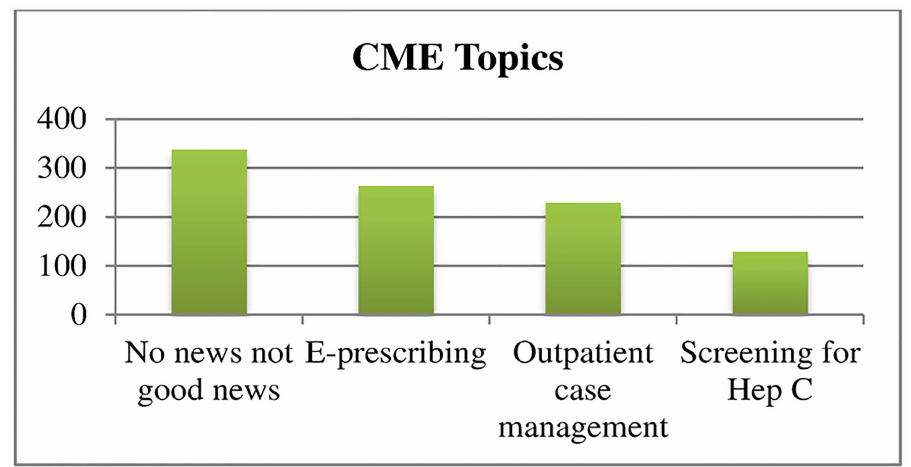
Fig 2. Estimated number of clicks by CME topic to landing site for a hypothetical campaign of six messages sent to 5000 recipients.